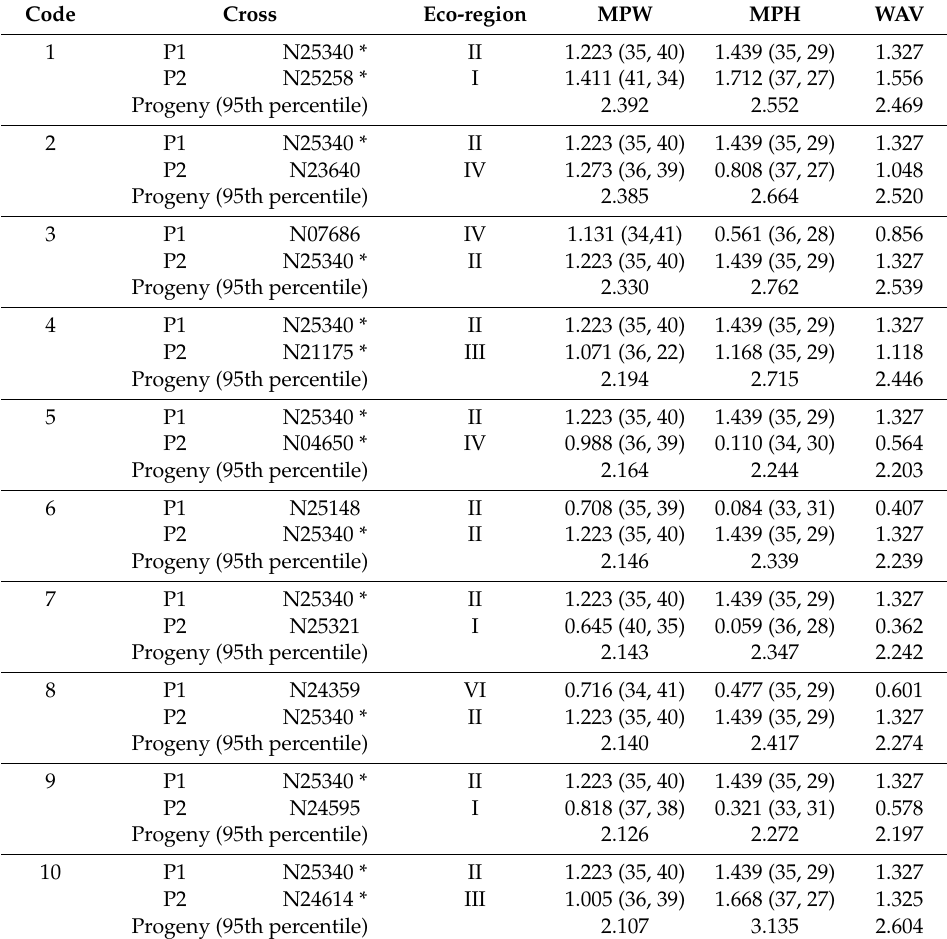
Table 6. The predicted optimal crosses for drought tolerance according to the 95th percentile values of